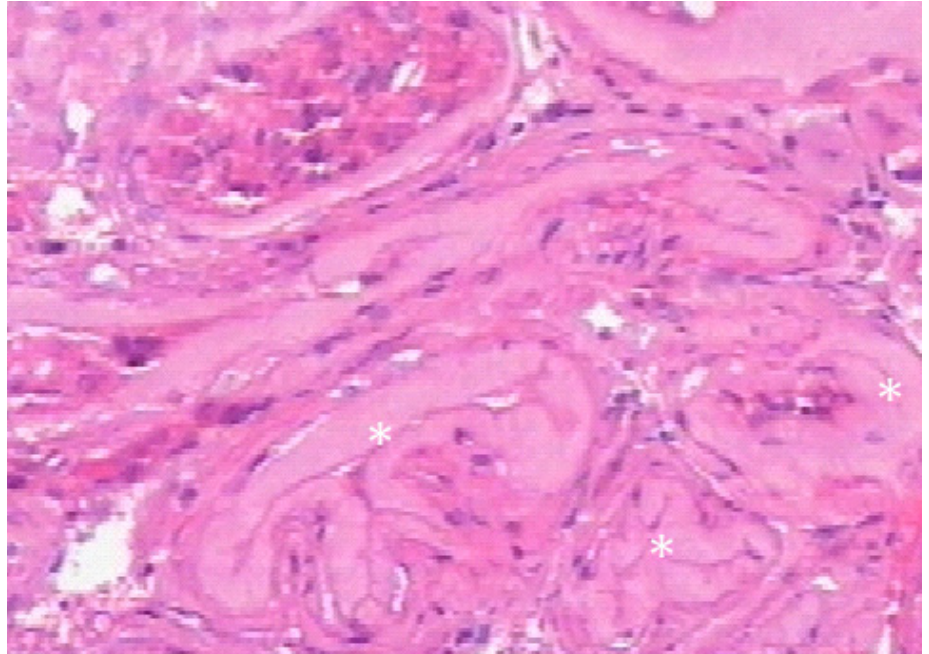
FIGURE 3 – Testis containing tubular atrophy (*) with complete absence of spermatogenic cells and marked thickening of the basement membrane (H&E,